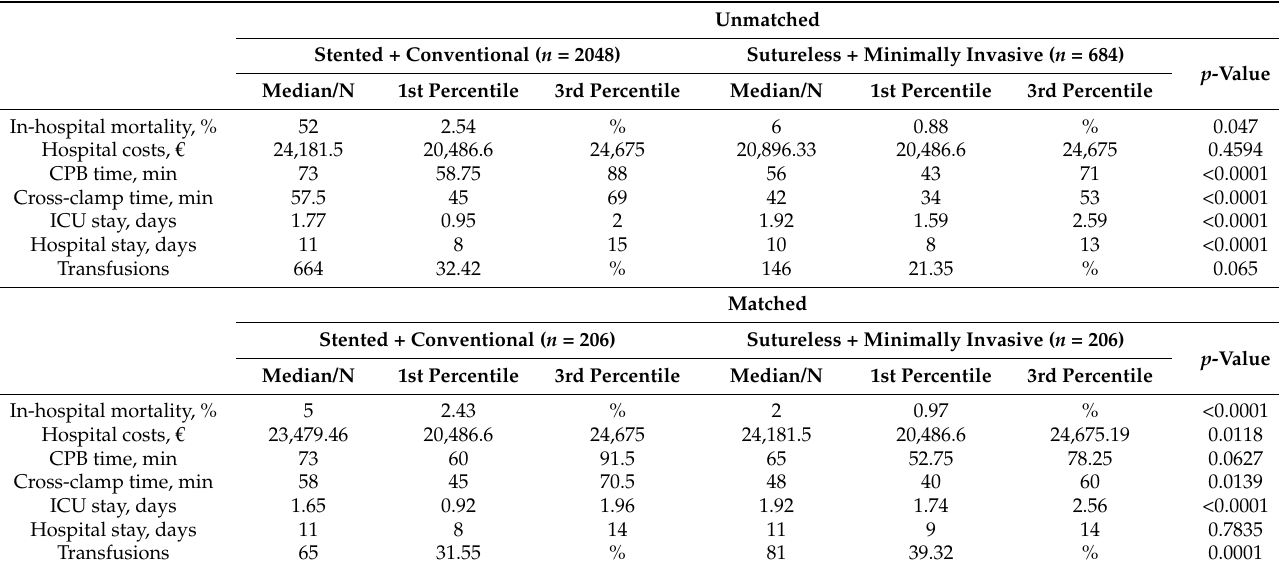
Table 2. Postoperative results before and after propensity score